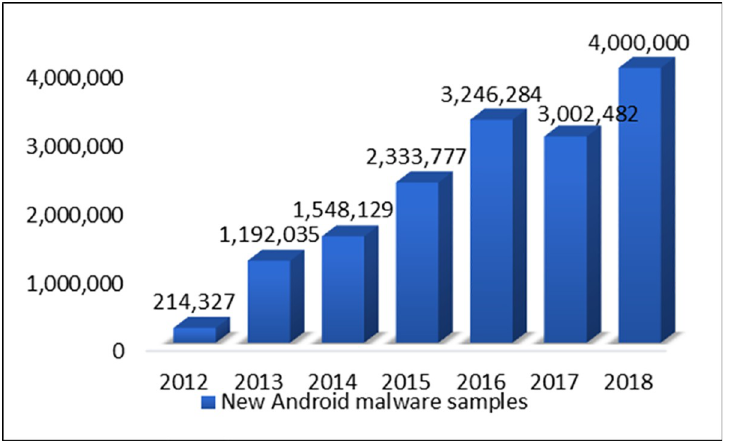
Fig 2. New Android malware samples